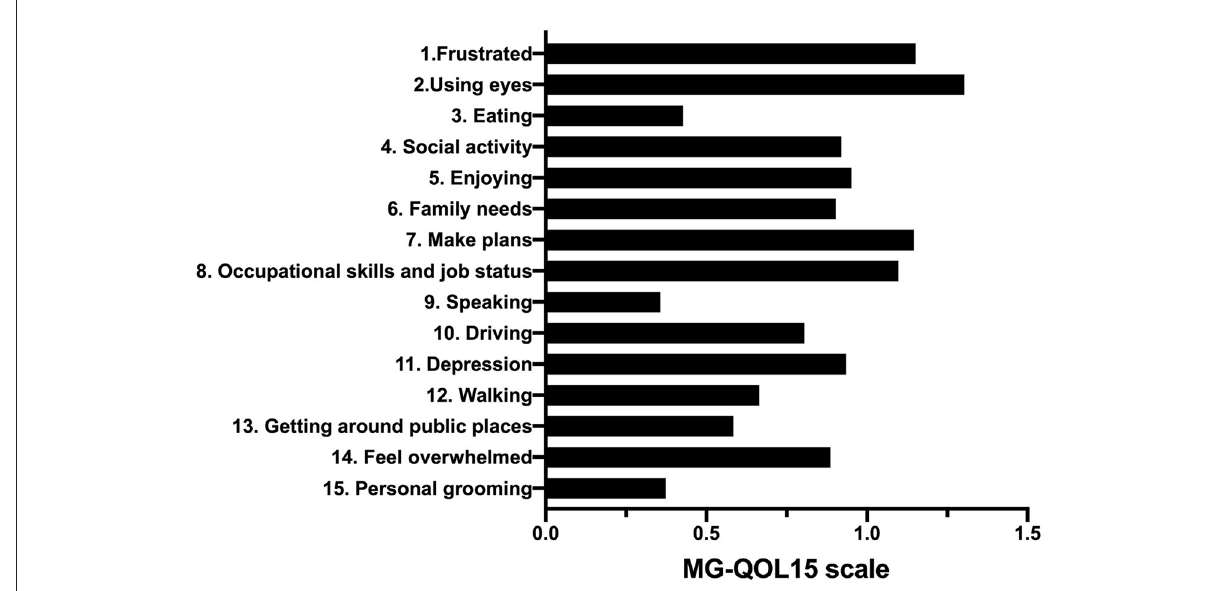
FIGURE2 The 15 items of the MG-QOL15 scale. MG-QOL15, the 15-item Myasthenia Gravis Quality of Life.